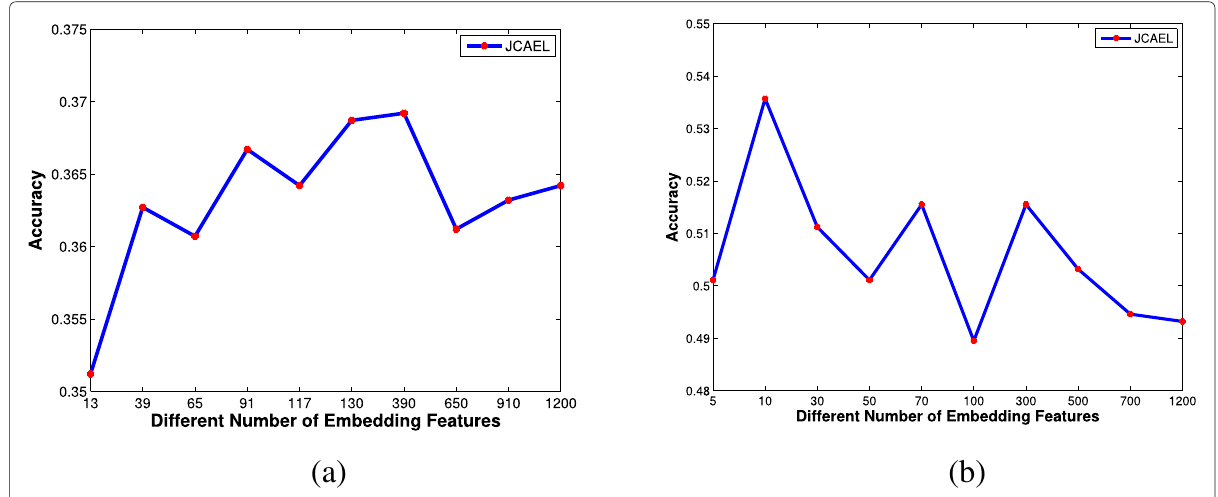
Fig. 6 The performance variation w.r.t the number of embedding features using our feature selection algorithm. a HMDB13 ← EID. b UCF10 ←